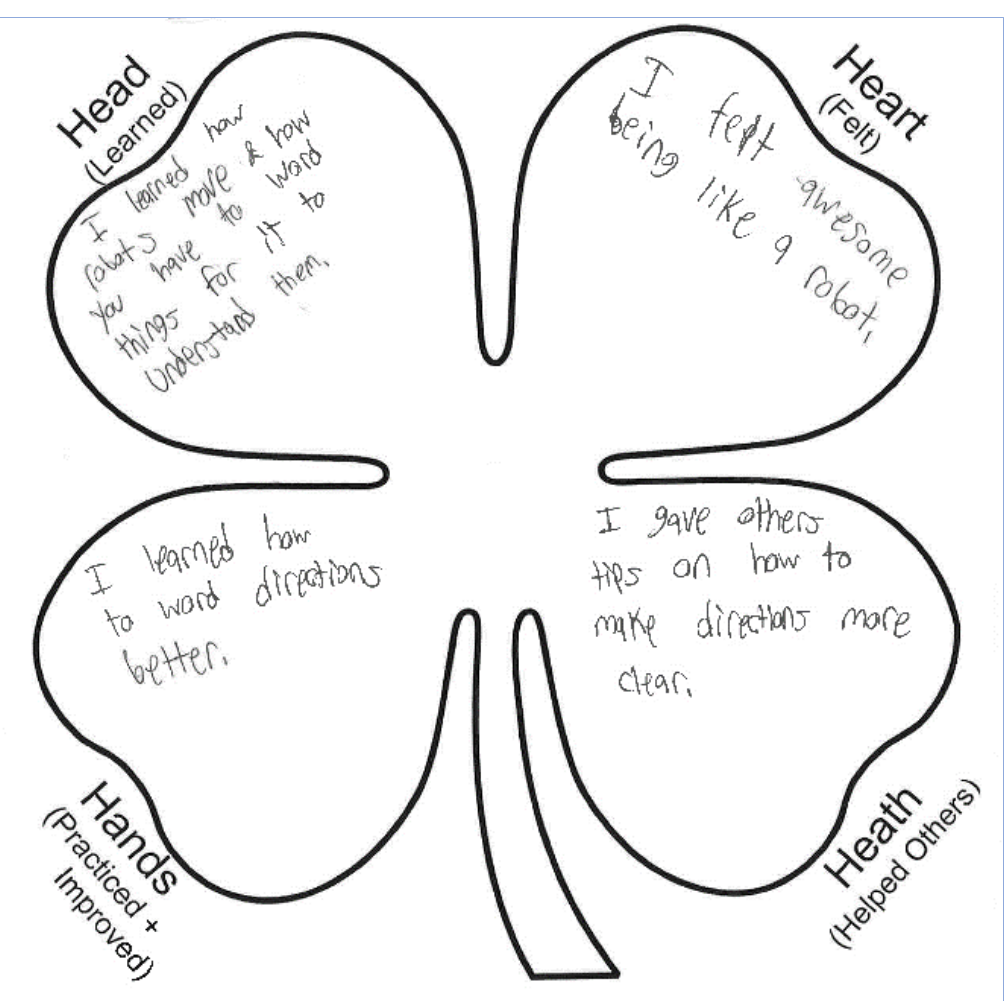
Figure A3. Example Response: Clover Reflection Sheet From Robotics Curriculum